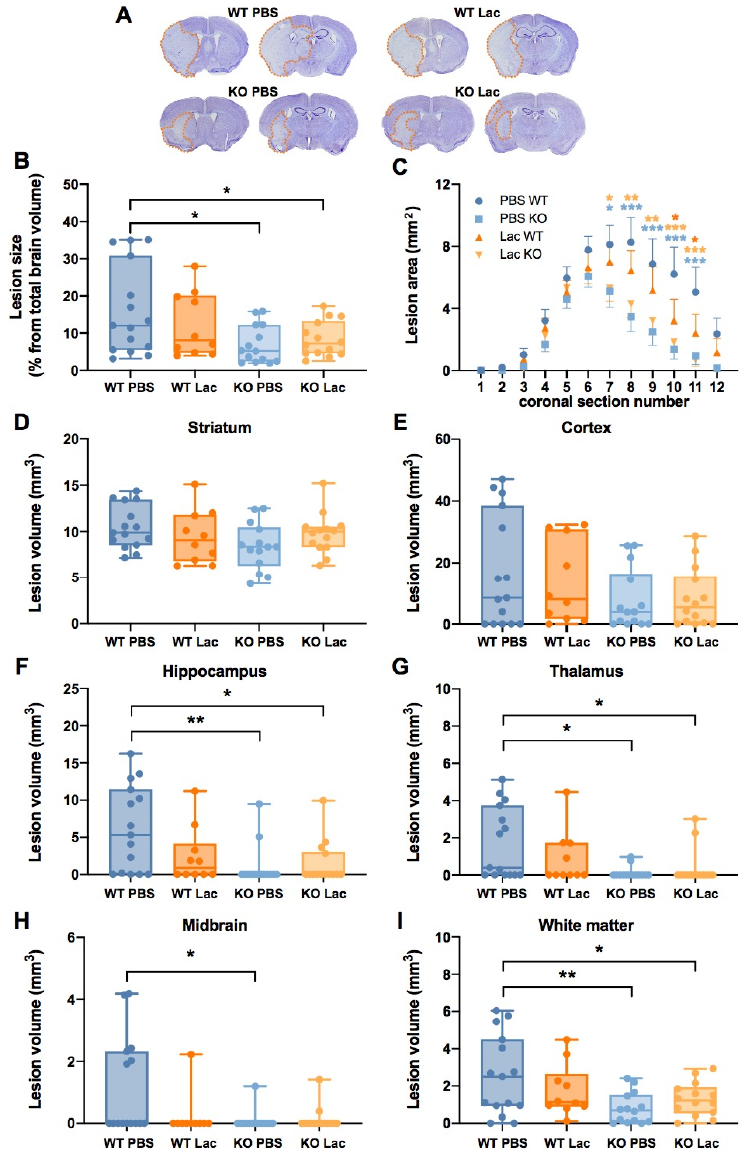
Figure 1. Effect of lactate on MCAO lesion size for WT and HCAR1 KO mice. ( A ) Representative images of cresyl violet-stained brain coronal sections of WT and HCAR1 KO mice subjected to transient MCAO and intravenously injected with PBS or lactate (Lac, 1 μmol/g) at reperfusion; lesions are outlined with a dashed orange line. Two images are provided for each condition, showing damage in the anterior ( left ) as well as posterior brain structures ( right ). ( B ) Total lesion size measurement. One-way ANOVA with Holm–Sidak’s post hoc test. ( C ) Measurement of the infarcted areas on individual coronal sections for the different conditions, showing that vehicle-treated WT mice suffered more extended damage. Two-way ANOVA with Holm–Sidak’s post hoc test. ( D – H ) Lesion volumes were measured in the following brain structures: ( D ) striatum; one-way ANOVA with Holm–Sidak’s post hoc test. ( E ) Cortex; Kruskal–Wallis with Dunn’s post hoc test. ( F ) Hippocampus; Kruskal–Wallis with Dunn’s post hoc test. ( G ) Thalamus; Kruskal–Wallis with Dunn’s post hoc test. correspond to significant differences between WT PBS and WT Lac, light blue stars to significant differences between WT PBS and KO PBS and light orange stars to significant differences between WT PBS and KO